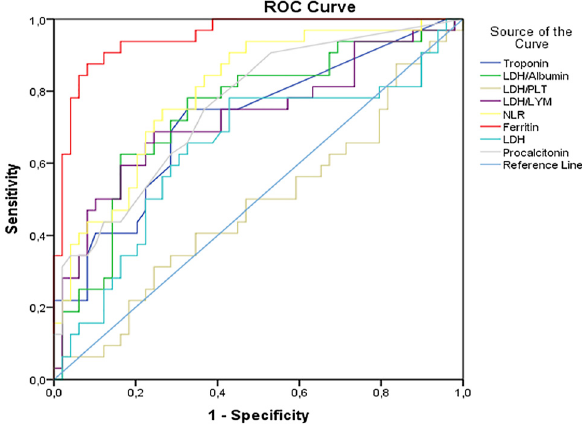
Figure 2: The ROC curves of LDH/Albumin, LDH/PLT, LDH/LYM, LDH, NLR, ferritin, procalcitonin, and troponin in predicting severe SARS-CoV-2 infection, on admission. PLT, platelet; LYM, lymphocytes; NLR, neutrophils-to-lymphocytes